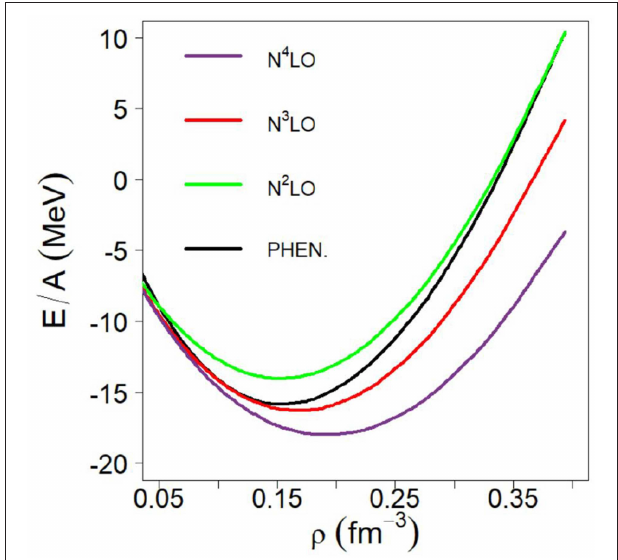
FIGURE 7 | The EoS of SNM at the three chiral orders considered here (cutoff fixed at 450 MeV) compared with the phenomenological EoS of Alam et al. [